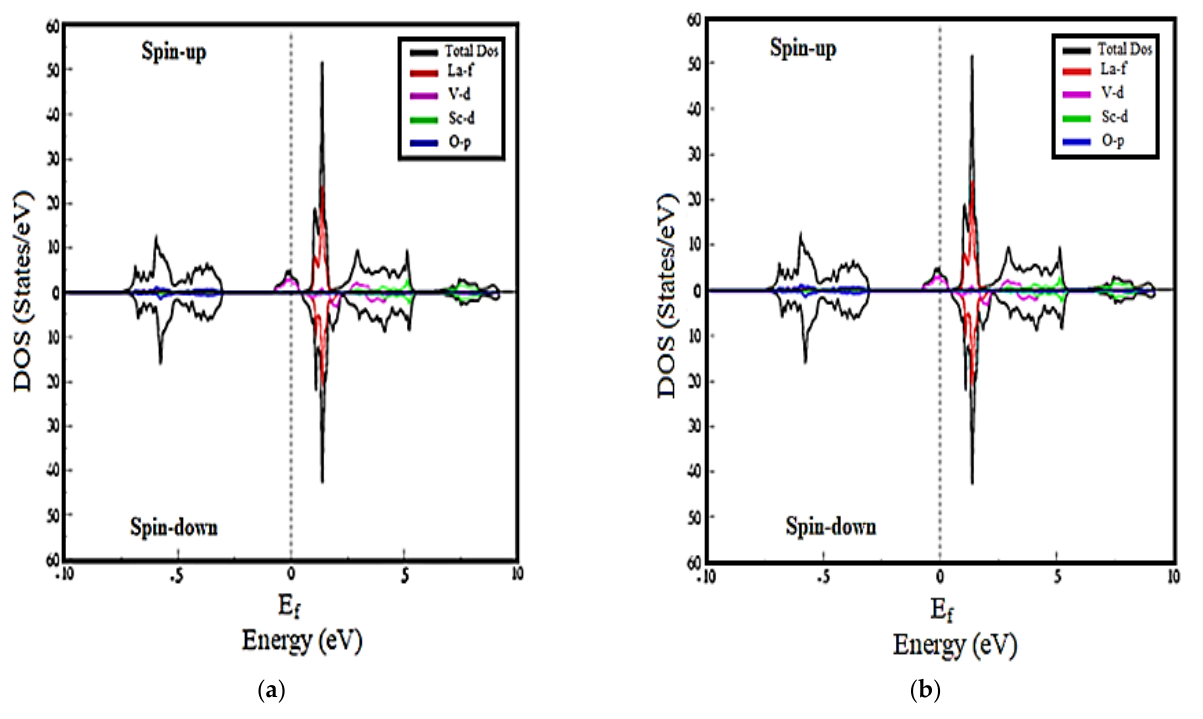
Figure 8. Density of states (DOS) of La 2 VScO 6 using ( a ) GGA and ( b ) GGA+U.